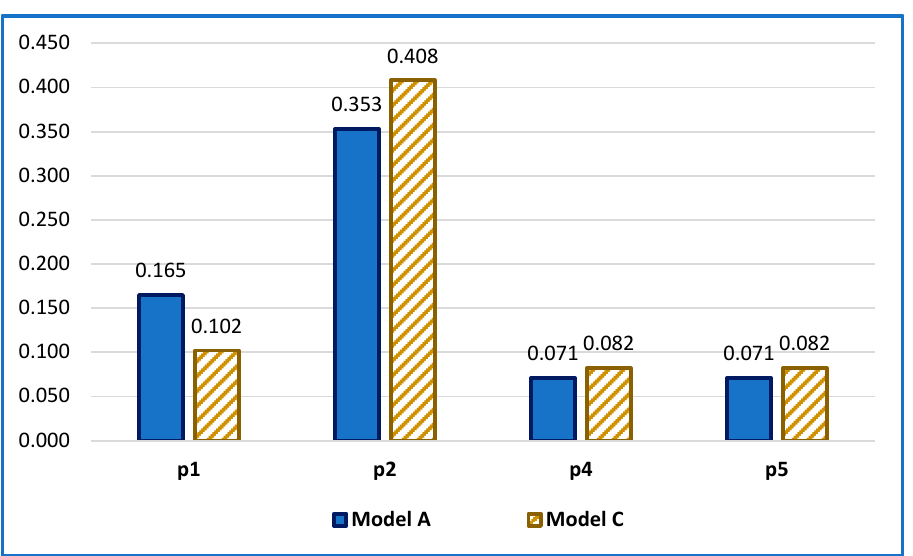
Figure 7. Equivalence of assessments before and after moving activities to the cloud (p A = p 3 + p 6 + p 7 for model “A”; p c for model “C”). Although moving certain process activities (6 *, 8 *, and 9 * of DFD [Figure 2]) to the cloud eases the workload of ISS service operators, it does not change the responsibility of the Data Controller or the requirement to ensure internal rules for identification and ac- cess management. Due to the fact that standard data protection mechanisms are tradition- ally applied in the cloud, the use of data centers and cloud services should only take place after providing serious guarantees for ensuring adequate data protection related to access